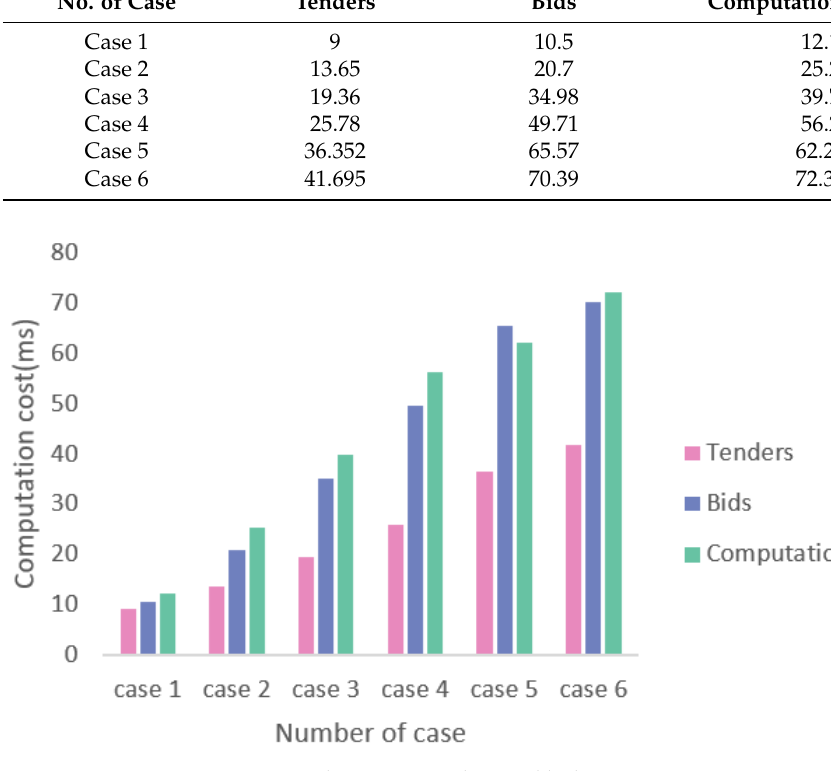
Figure 11. Computation cost with various tenders and bids.